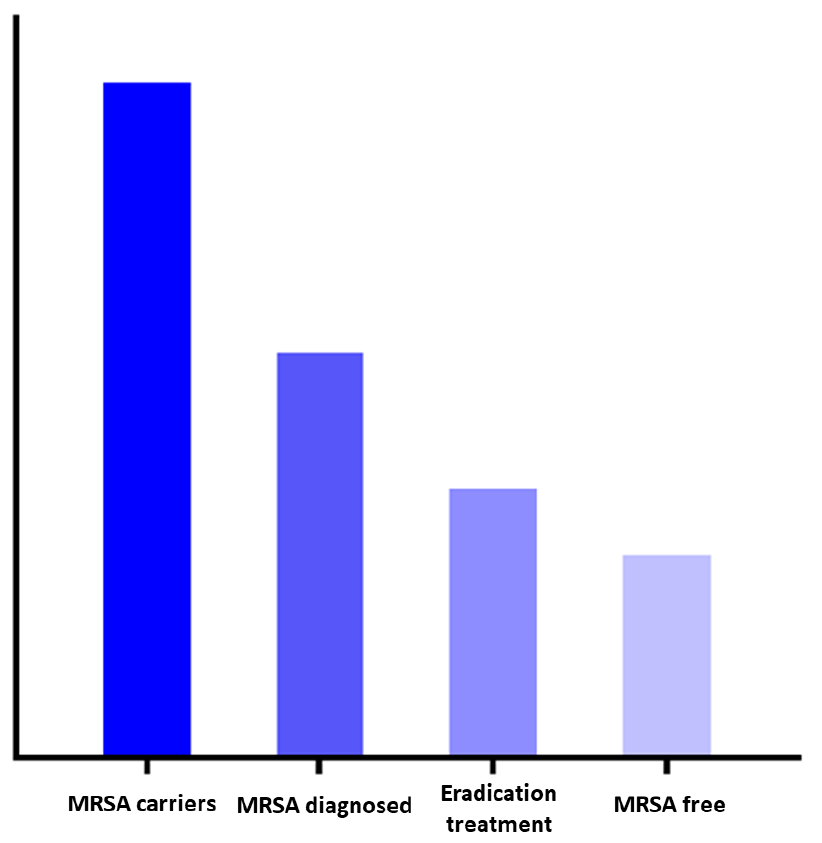
Figure 1. Conceptual graphic of the cascade of care in MRSA decolonization. Legend: The first column addresses the total number of MRSA carriers in the Netherlands. The second column represents the proportion of carriers that is diagnosed. The third column addresses the MRSA carriers that are diagnosed and undergo eradication treatment. The last column represents the success rate of complicated MRSA eradication treatment. In every step of this conceptual cascade of care, there is the potential for leakage. As this figure represents a conceptual model, the columns are not quantified.